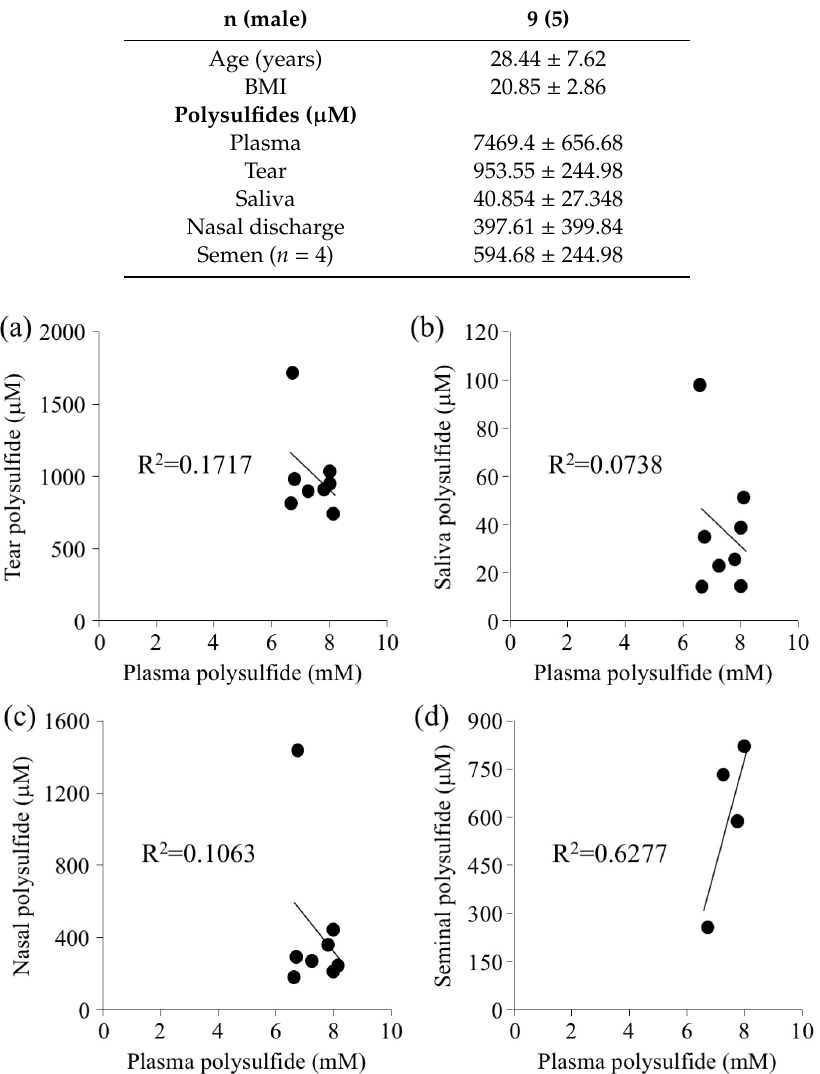
Figure 1. Correlation between the plasma polysulfide level and that of a biological fluid. Each polysulfide level was measured by EMSP. ( a ) tear polysulfide, ( b ) saliva polysulfide, ( c ) polysulfide in nasal discharge, and ( d ) seminal polysulfide.